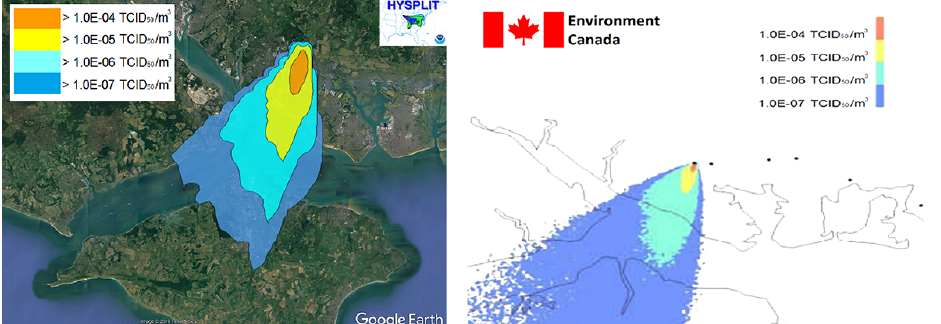
Figure 2. Dispersion plume of FMD from HYSPLIT model for the 1967 Hampshire FMD case study (left). This represents a 24h time averaged concentration for the test day of the 9 January 1967 driven by 1 ◦ ECMWF ERA-40 reanalysis meteorological data. This compares well to the same event modelled by the Canadian MLCD dispersion model (right), one of 6 FMD dispersion modelling groups to participate in the FMD intercomparison exercise. The island at the bottom of both images is the Isle of Wight, UK. Concentrations in TCID 50 (50% Tissue Culture Infective Dose). Left panel background map © 2019 Google Earth, © 2019 TerraMetrics, Data SIO, NOAA. U.S. Navy, NGA, GEBCO, adapted by the authors. Right panel adapted from Gloster et al. (2010), Fig.